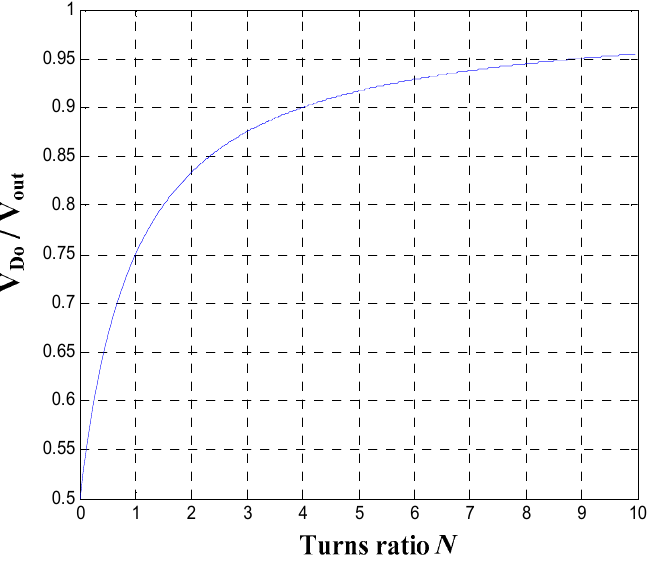
Figure 7. Relation curves between turns ratio and normalized output diode voltage stress ratio. The voltage stress of the diode D f is: